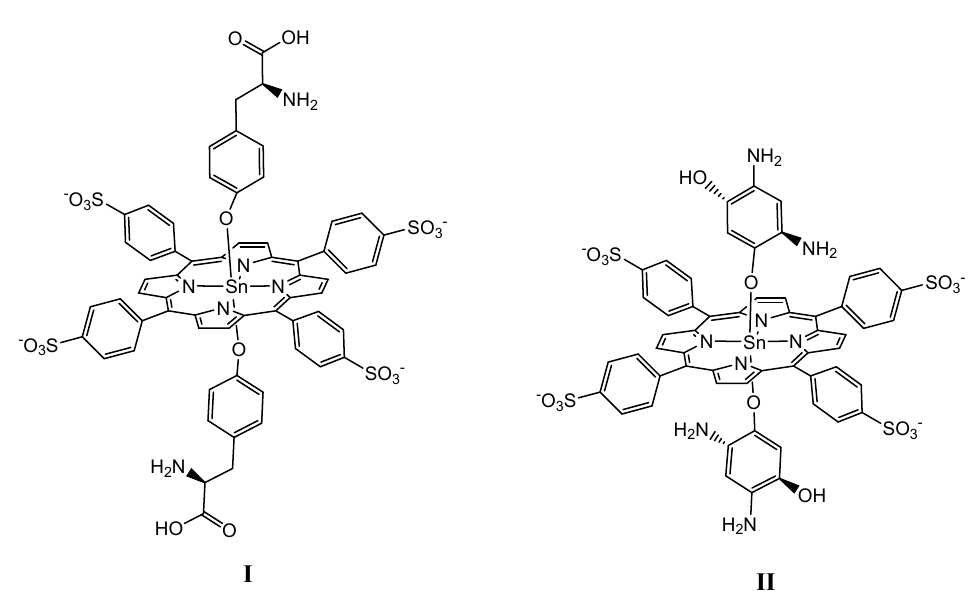
Figure 1. Structures of the complexes I and II.